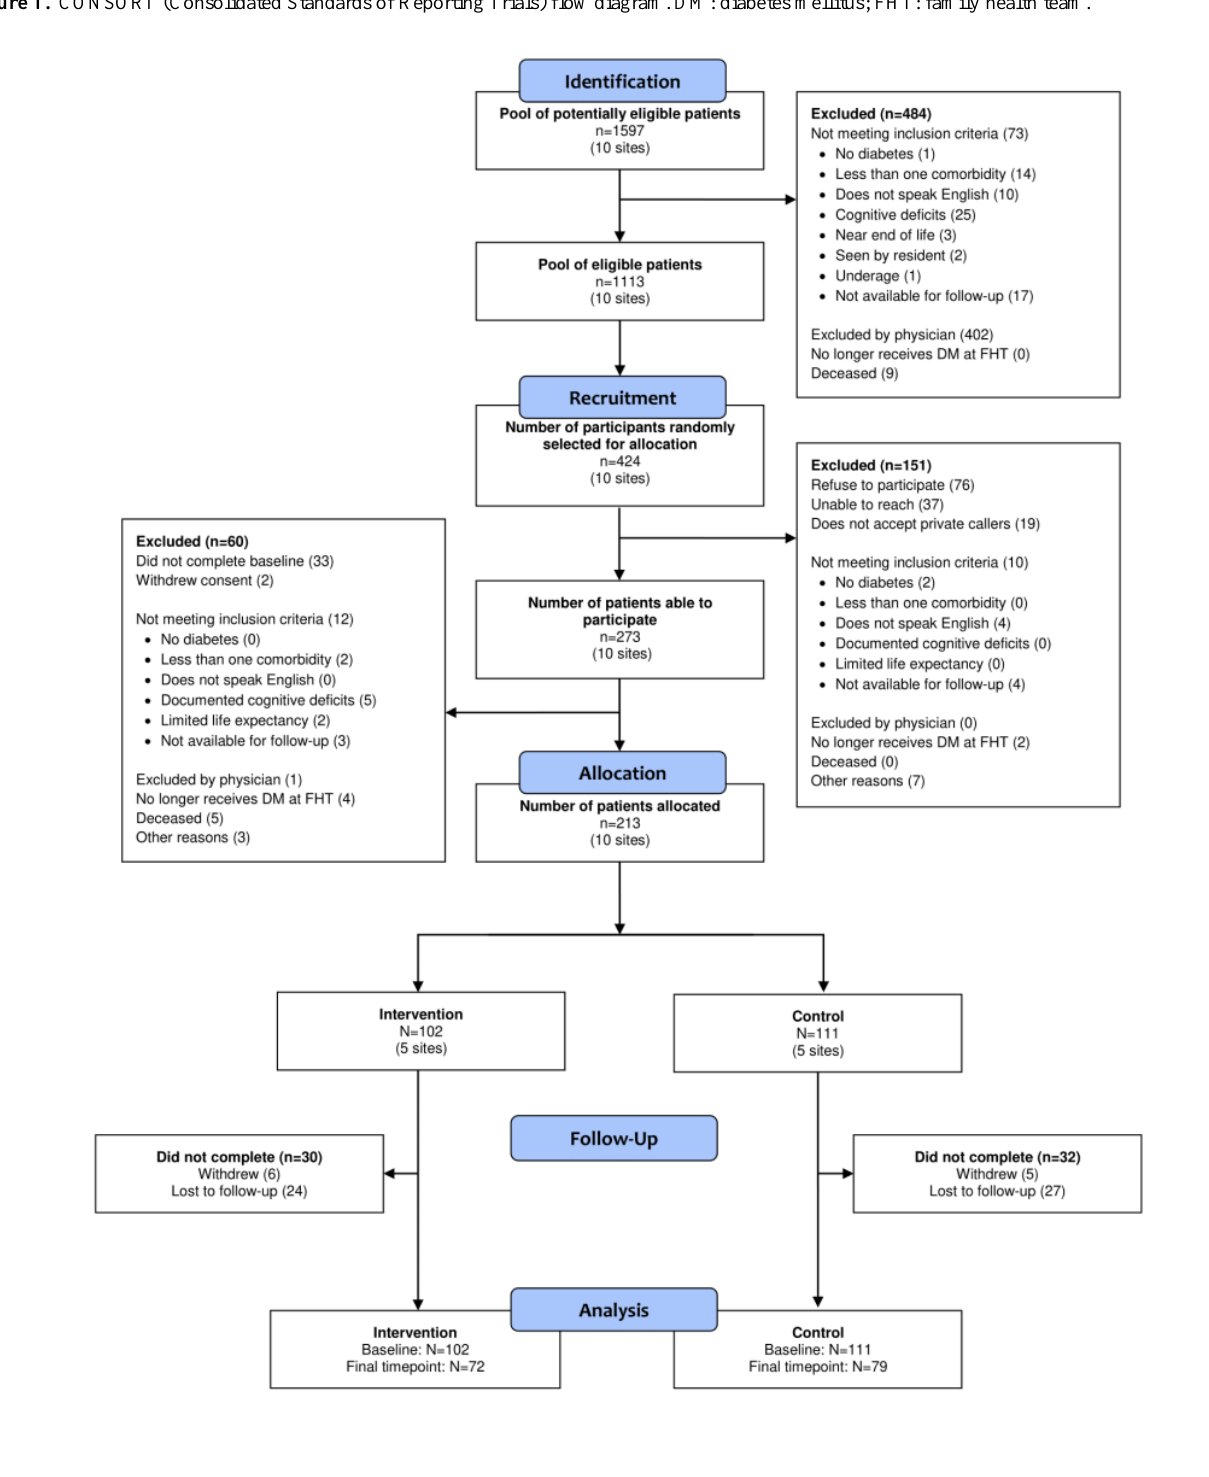
Figure 1. CONSORT (Consolidated Standards of Reporting Trials) flow diagram. DM: diabetes mellitus; FHT: family health